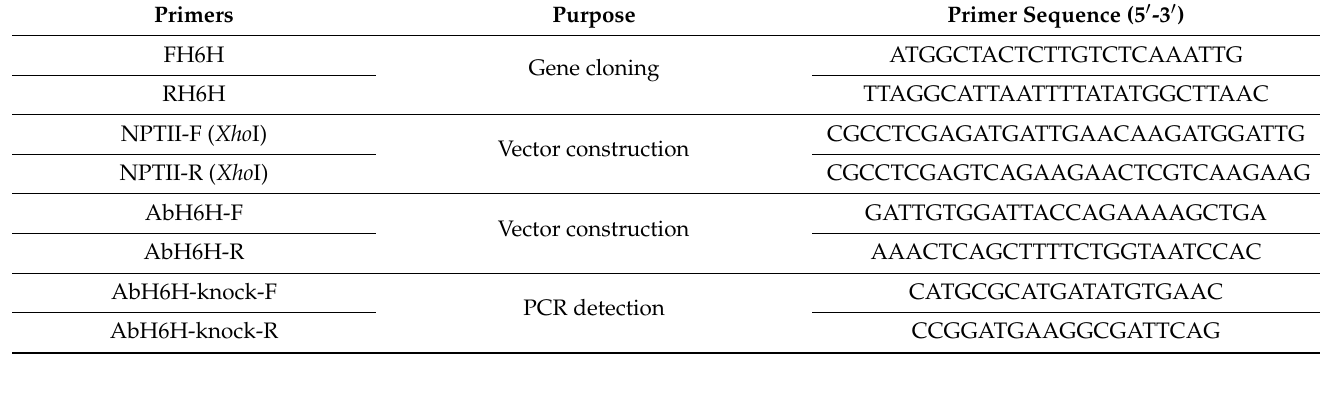
Table 1. Primer information.